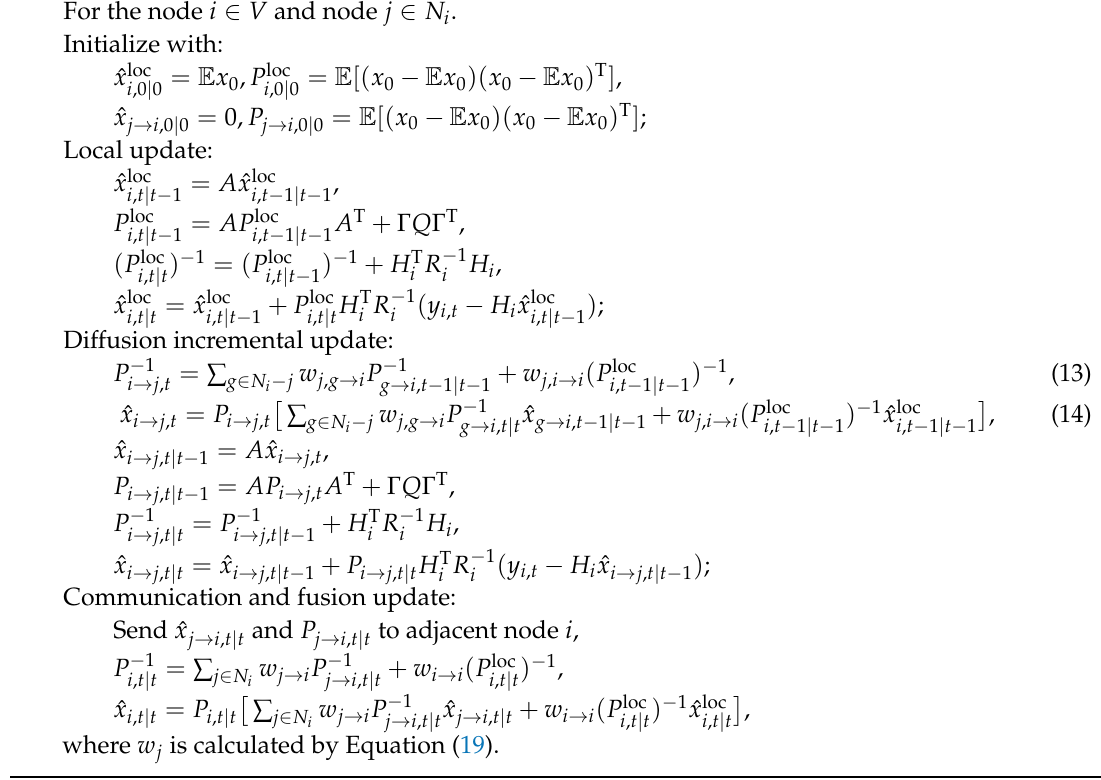
Algorithm 6: A distributed Kalman filter based on the non-repeated diffusion strategy. For the node i ∈ V and node j ∈ N i